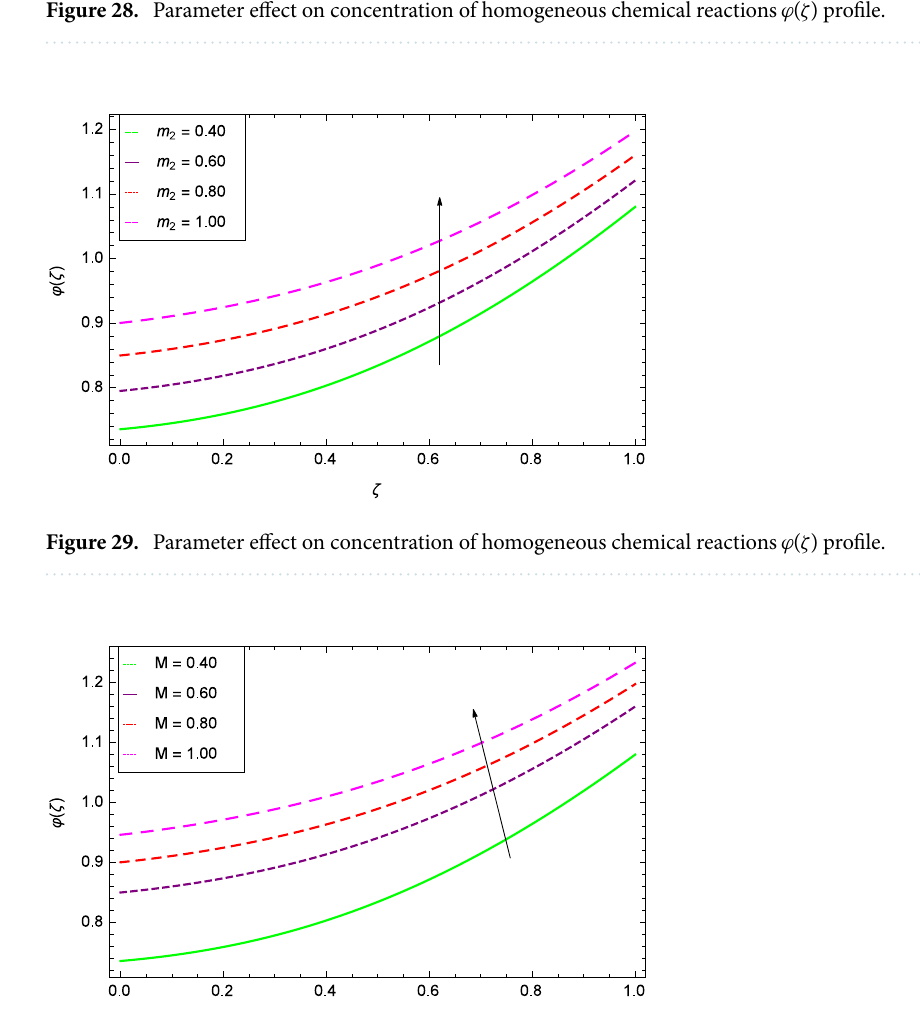
Figure 28. Parameter effect on concentration of homogeneous chemical reactions ϕ ( ζ ) profile.